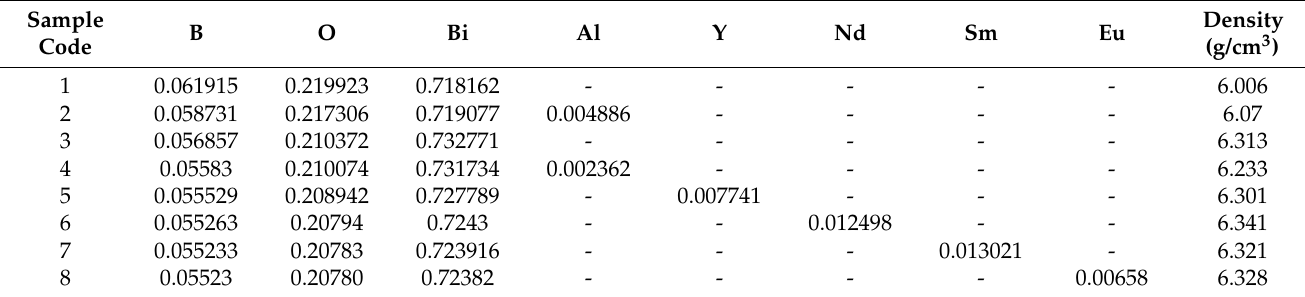
Table 1. The codes, elemental compositions, weight fractions and densities of the studied glass samples.